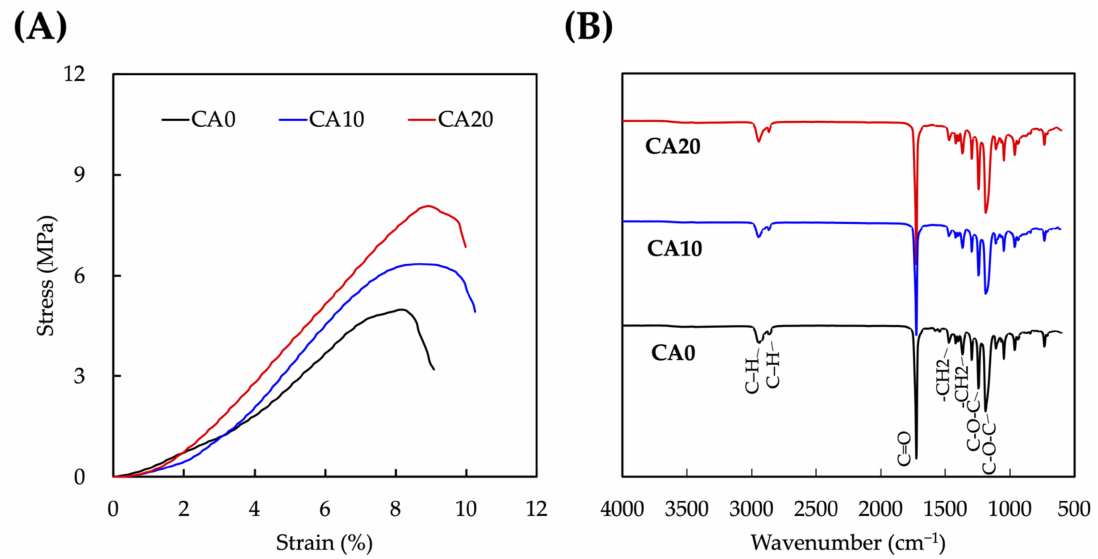
Figure 2. ( A ) Stress–strain curve and ( B ) Fourier transform infrared spectroscopy results of CA0, CA10, and